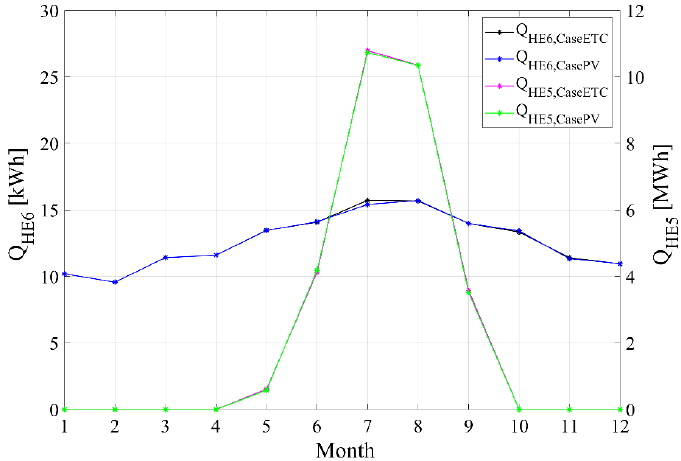
Figure 9. Ground heat exchanger energy performance.